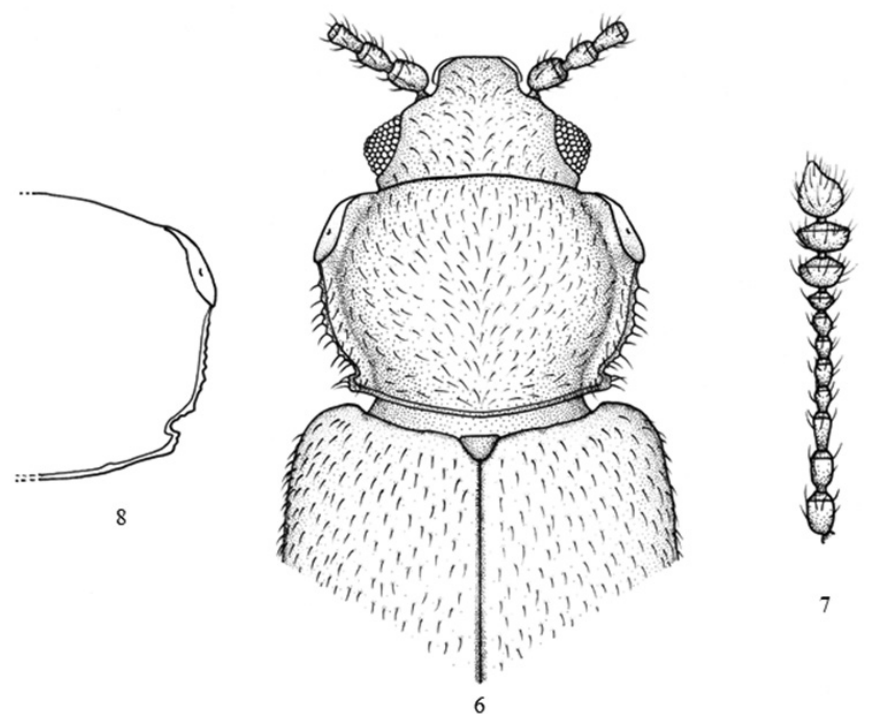
Figures 6–8. Micrambe brevitarsis : 6 General view 7 antenna 8 pronotum.